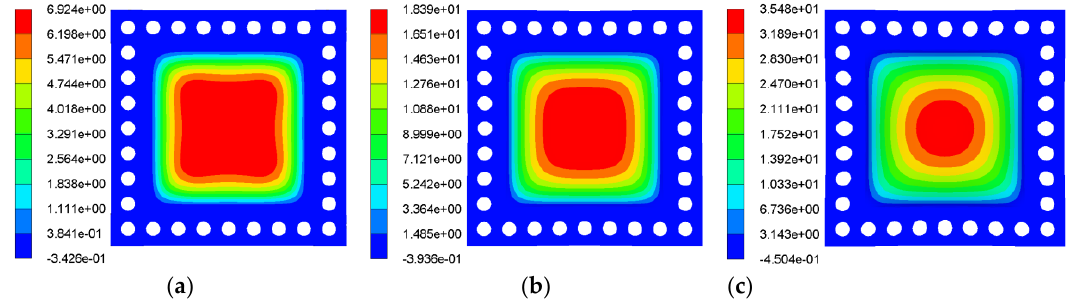
Figure 5. Deformation contour plot of the test plate (Case FC-3–6) at different times. ( a ) T = 0.18 ms; ( b ) T = 0.30 ms; ( c ) T = 0.50 ms.